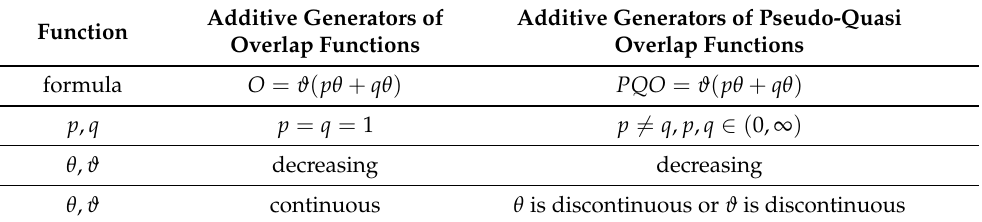
Table 1. Additive generators of overlap functions and pseudo-quasi overlap